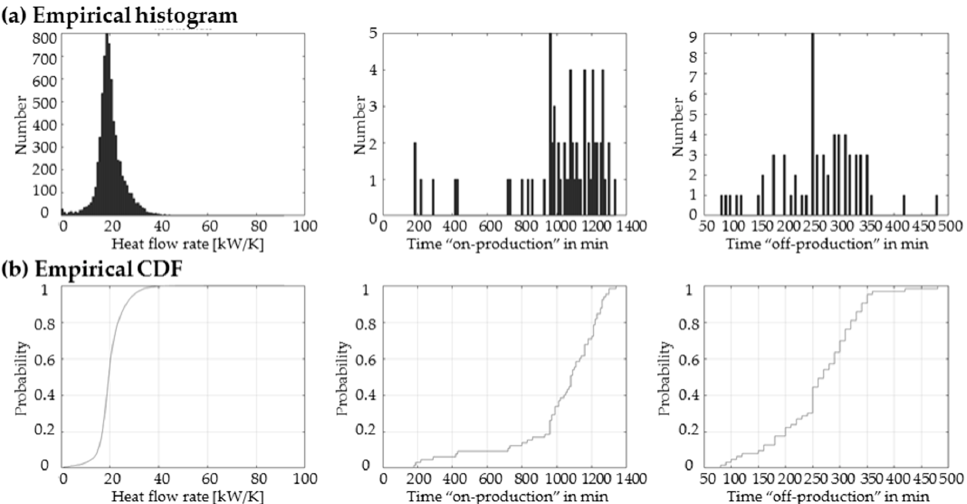
Figure 5. ( a ) Histograms and ( b ) empirical cumulative distribution functions (CDF) of the heat flow rate, duration of “on-production” and duration of “off-production” for the example of Whey A. The generation of the time series begins with the decision of whether production is “on” or “off”. The probability for this decision is calculated by the mean value from the mean duration of the “on” and “off” periods. The CDF based on the cumulative frequency plots of the heat flow rate (Figure 5b) over the production period is used to set probable heat flow rate for every time step during the operating state "on-production", by which the demand is scattered with the corresponding variance. The distributed durations of the operating states t on for "on-production" and t off for "off-production" can also be determined from the CDF functions (Figure 5b).